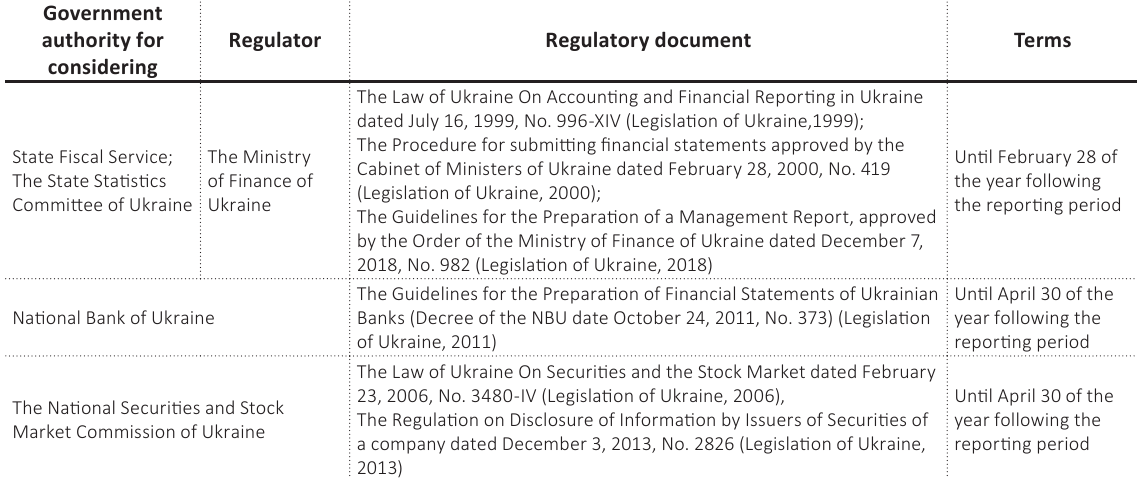
Table 1. The procedure for regulating and publishing management reports by banks in Ukraine and their